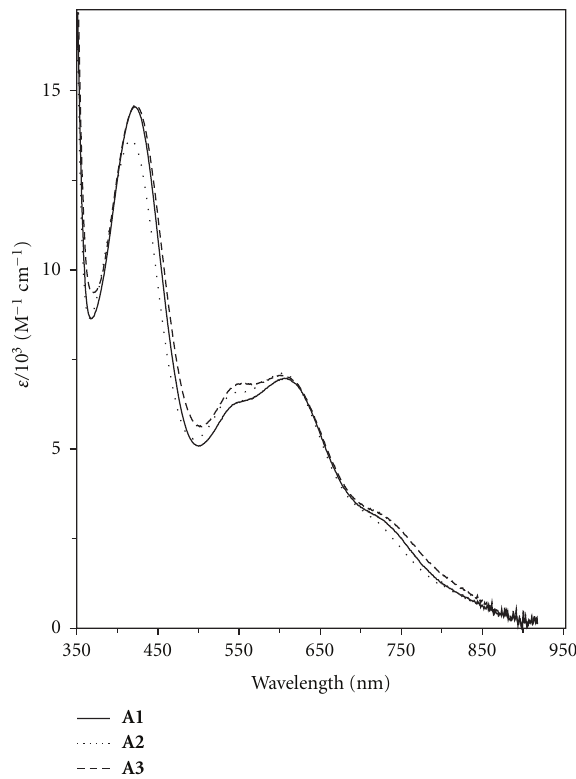
Figure 2: UV-vis absorption spectra of complexes A1 , A2 , and A3 in ethanol-methanol (4: 1) solution.